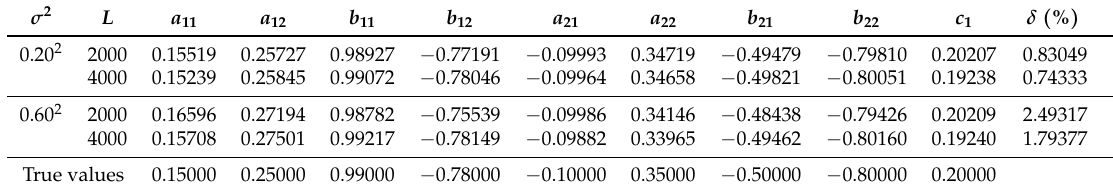
Table 4. The F-LSI parameter estimates and errors for Example 1 ( k =